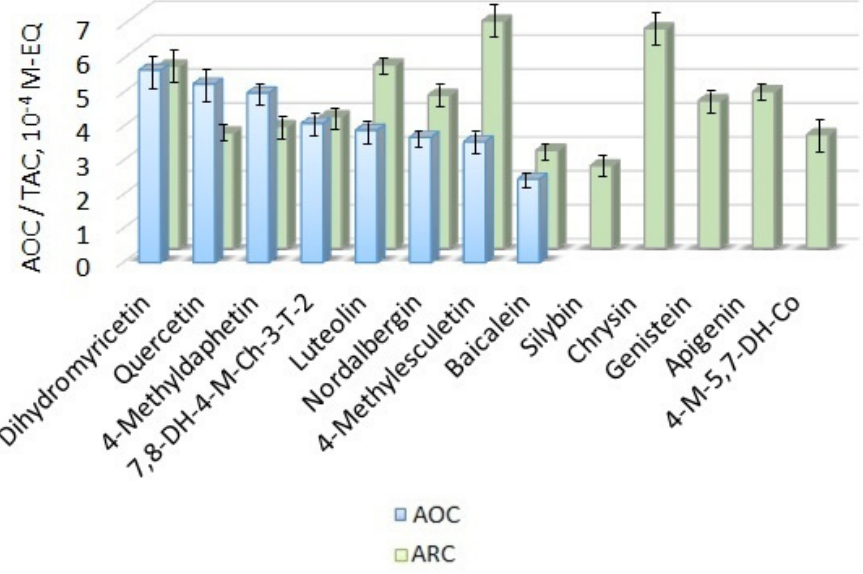
Figure 5. AOC and ARC of flavonoids and Figure 5 . AOC and ARC of flavonoids and coumarins .